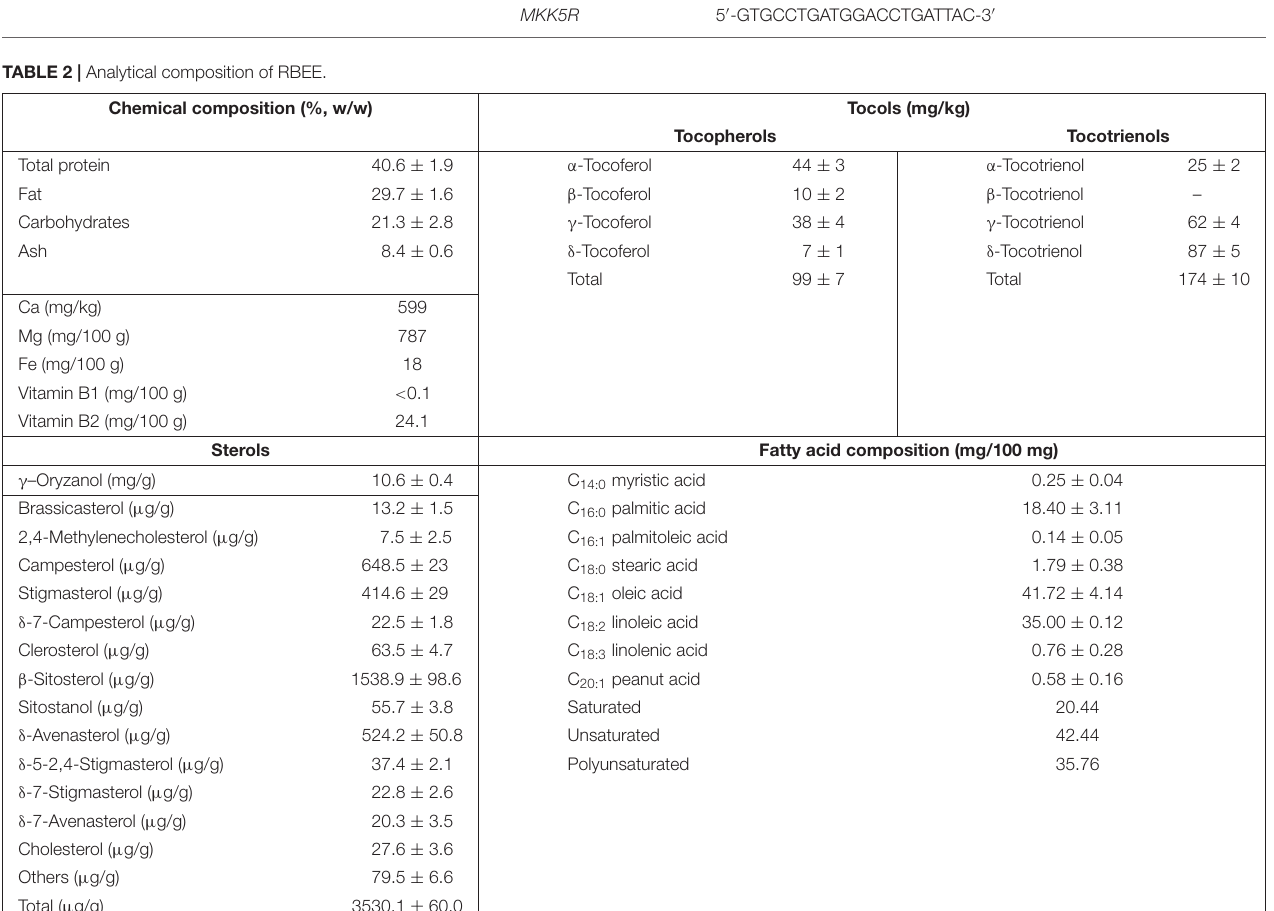
TABLE 2 | Analytical composition of